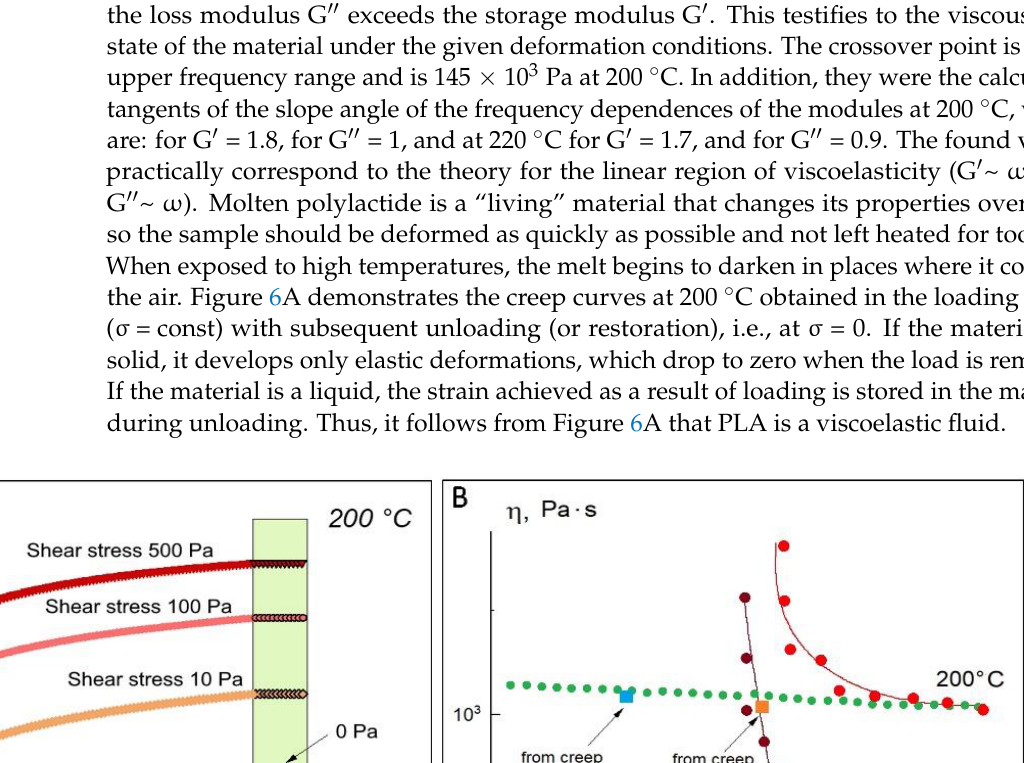
Figure 5. Frequency dependences of elastic and loss moduli for polylactide at different temperatures.